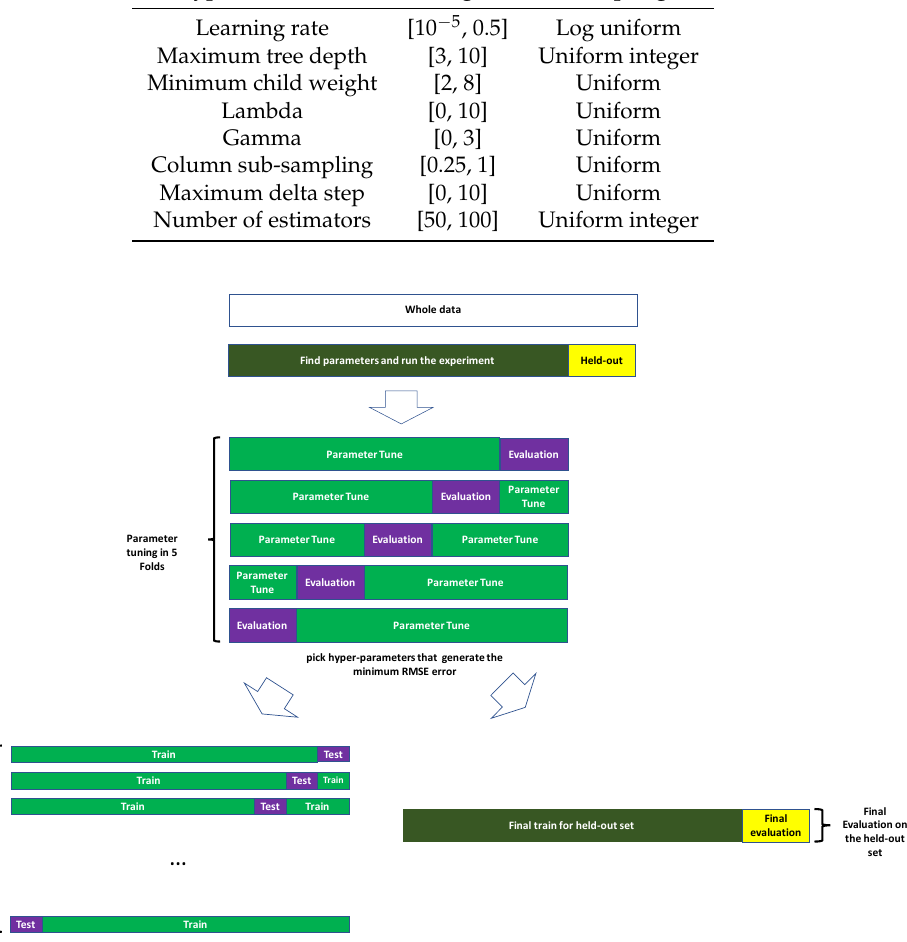
Figure 2. Overall pipeline: First, a hold-out set is separated for the final evaluation. Then for each microbe and each feature extraction method, hyper-parameter tuning is done on one antibiotic with 5 folds of cross-validation, which results in 5 different sets of hyper-parameters in the end. The parameter set that minimizes the RMSE is chosen for 2 experiments: Cross-validation using 10 folds, and a final evaluation on the hold-out